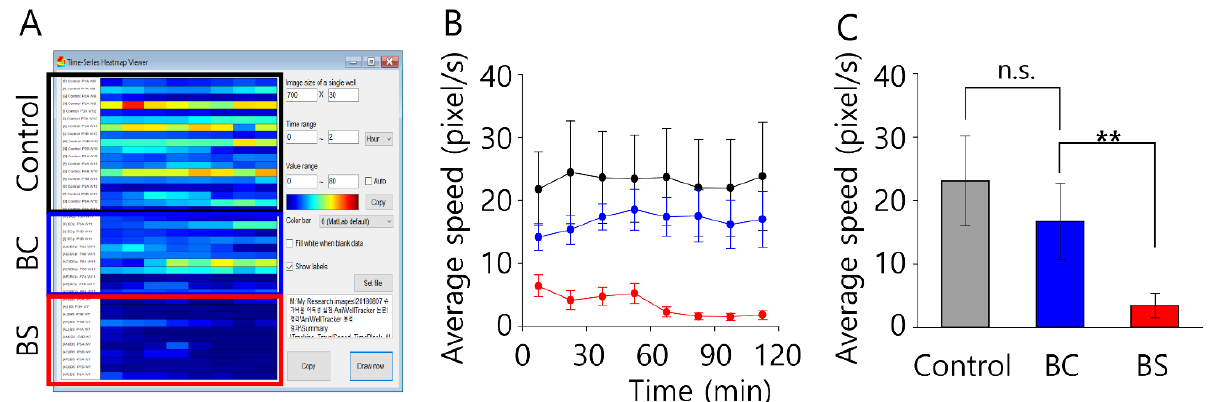
Figure 5. A case study of the effect of household cleaning agents on the swimming speed of zebrafish. ( A ) After image analysis with AniWellTracker, the average speed of individual animals over time was displayed as a heatmap chart in the time series heatmap viewer window. Individual rows represent different animals. ( B ) From the raw data of A, the average speed and 95% confidence interval of several animals per hour were calculated and plotted as a chart. ( C ) The average speed over 2 h was finally plotted as a bar graph. n.s.: not significant, **: p -value < 0.01.